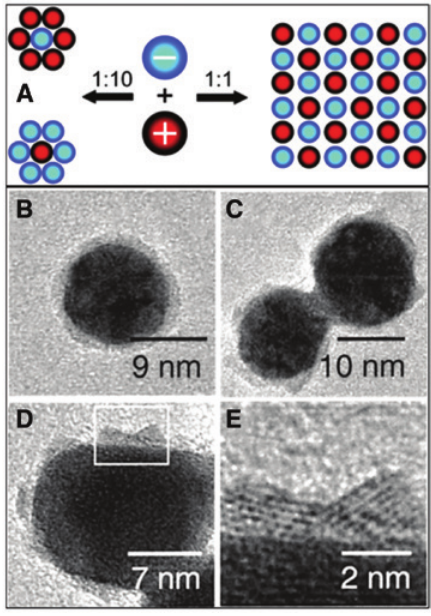
Figure 4: Self-assembly of AuNPs and CdS QDs. (A) Schematic depicting two possible self-assembly routes: a 1:10 ratio of oppositely charged nanoparticles, which leads to isolated particles surrounded by a layer of oppositely charged particles, or a 1:1 ratio, which leads to a large interconnected network. (B–E) High-resolution TEM images depicting AuNPs with a layer of CdS QDs coating the surface. Adapted with permission from Ref. [36]. Copyright 2002 American Chemical